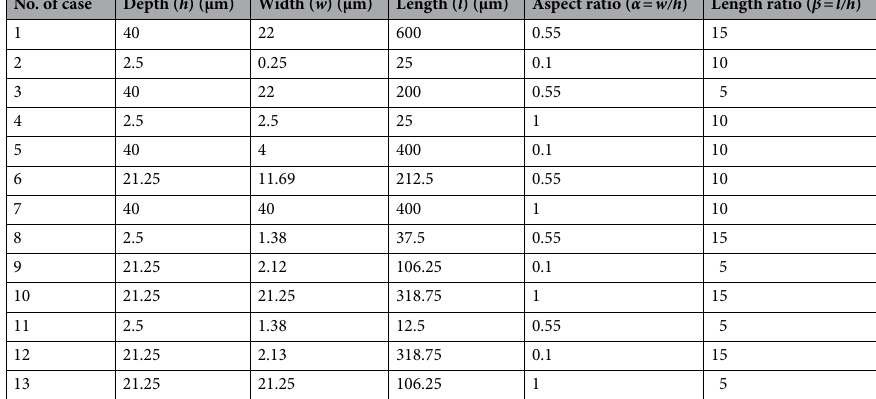
Table 3. Initial surface flaws in the OT wire.